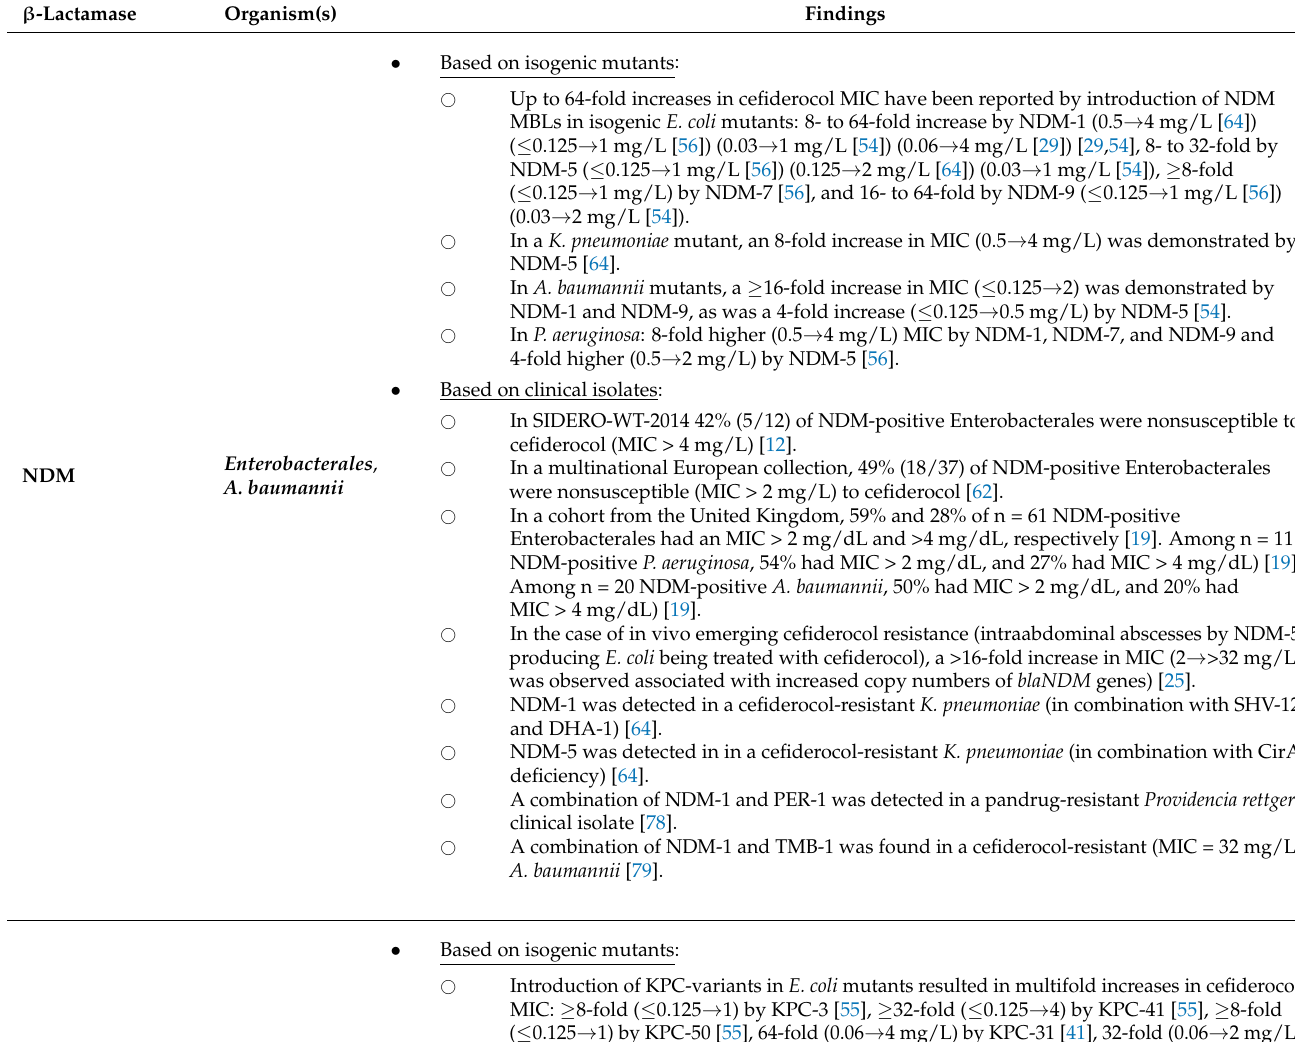
Table A1. Role of β -lactamases in cefiderocol resistance.